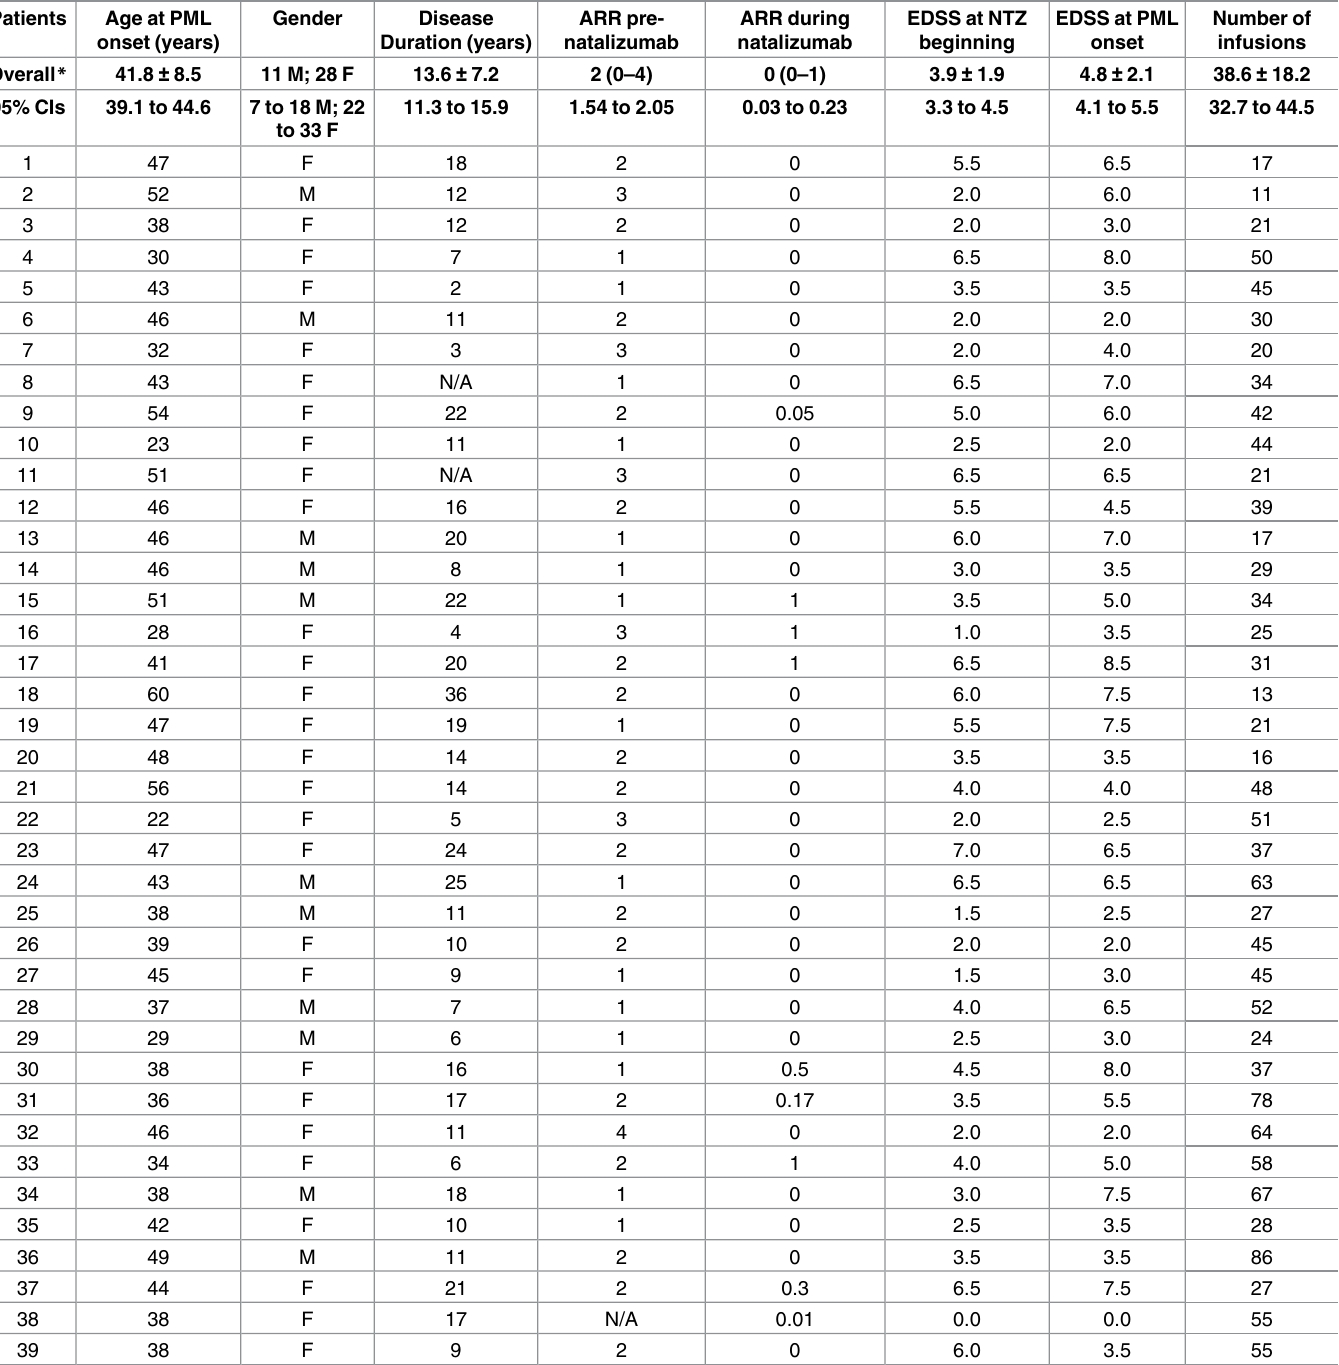
Table 1. Socio-demographic and clinical features of each individual patient (n =